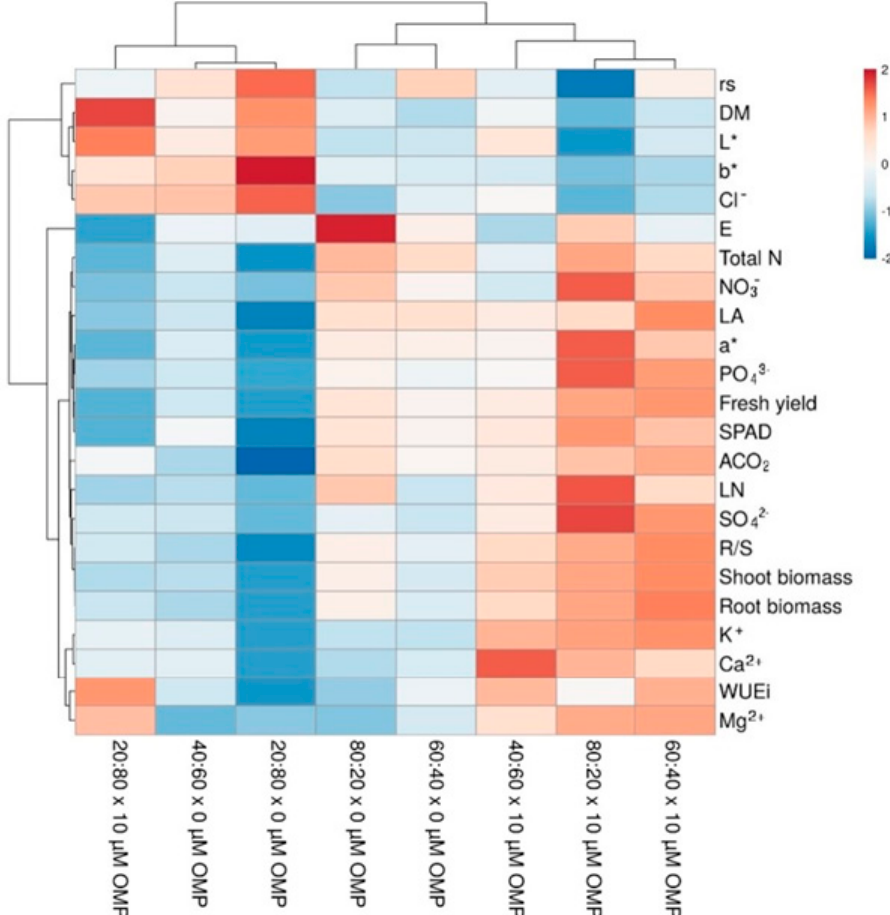
Figure 2. Cluster heat map analysis summarizing plant responses to drench application of (0 μ M and 10 μ M OMP) and different NO 3 − :Cl − ratios in the nutrient solution (80:20, 60:40, 40:60, and 20:80). It was generated using the https://biit.cs.ut.ee/clustvis/ online program package with Euclidean distance as the similarity measure and hierarchical clustering with complete linkage.